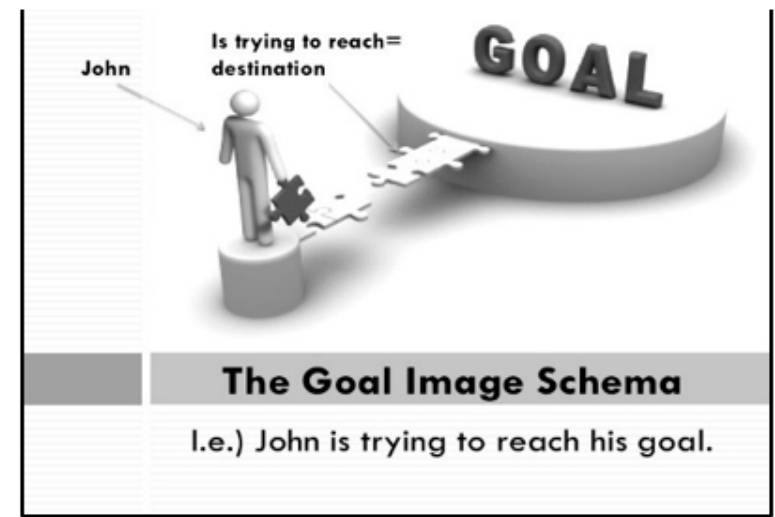
Figure 4. The goal Image Figure 4. The GOAL Image Schema.